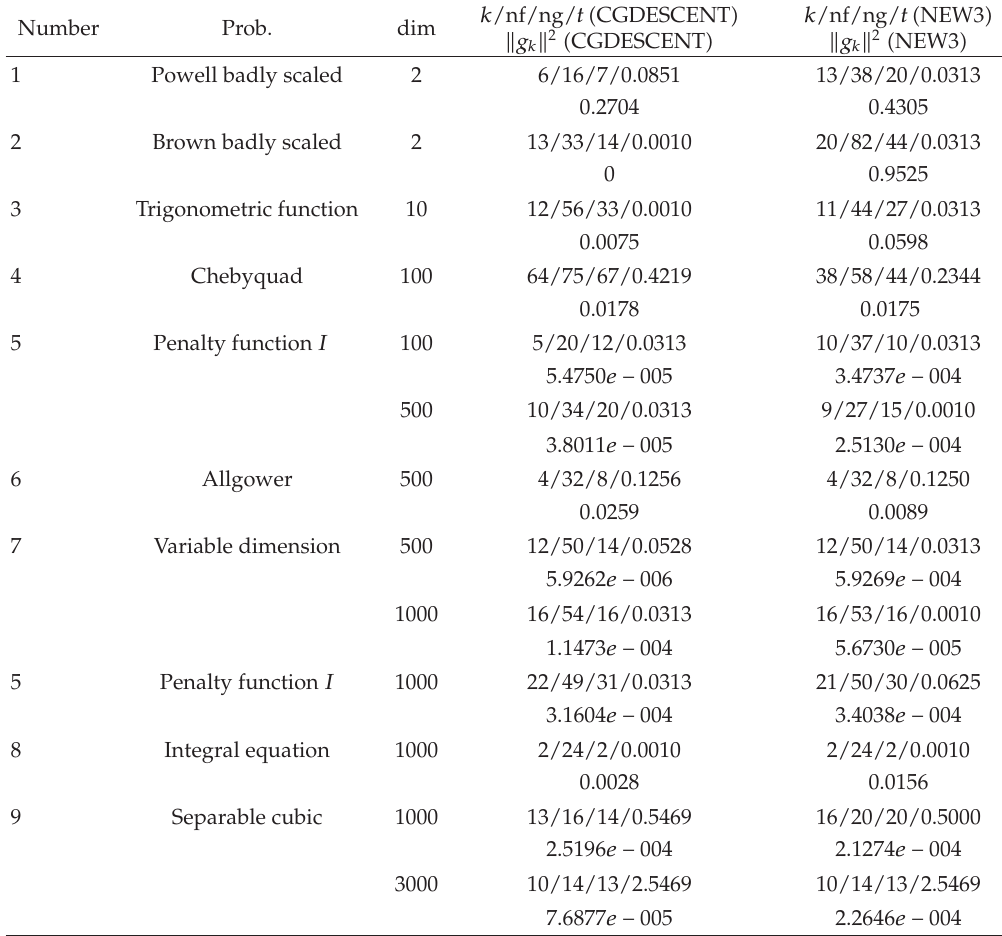
Table 2: Numerical results of the CGDESCENT and